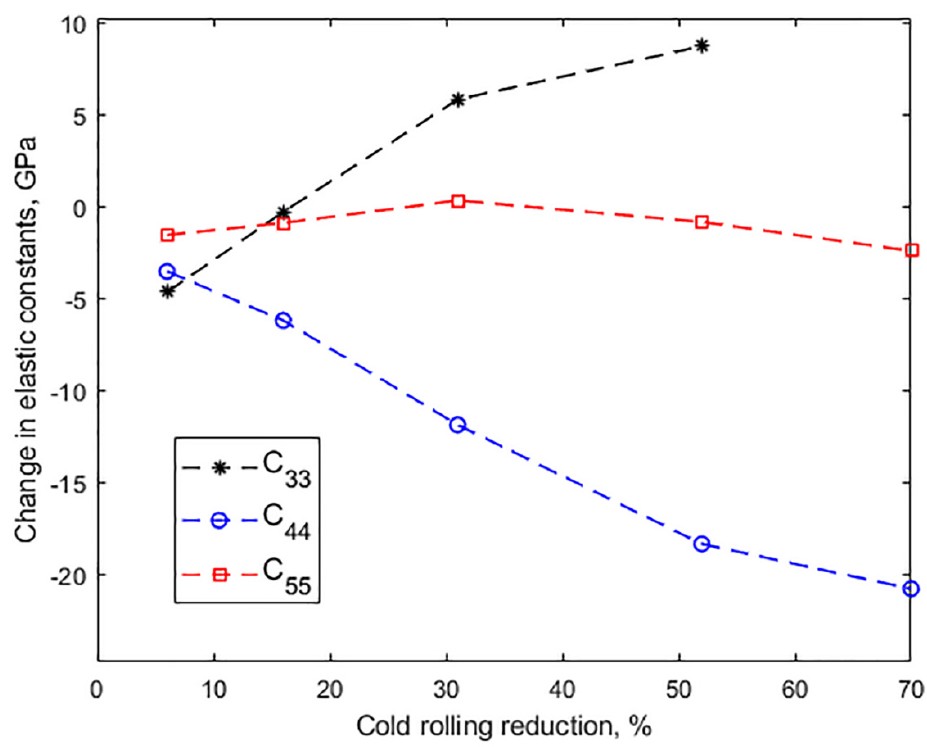
Figure 4. Effect of the thickness reduction by cold rolling on the change in elastic constants.